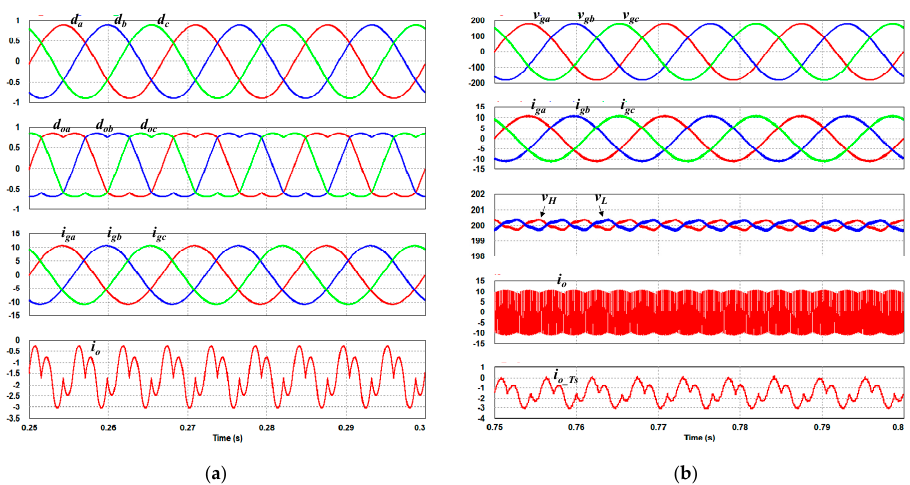
Figure 7. Simulation waveforms at unity power factor operation under unbalanced load conditions. ( a ) Average model ( d a , d b , d c : original duties; d oa , d ob , d oc : final duties considering the SVM and o ff set